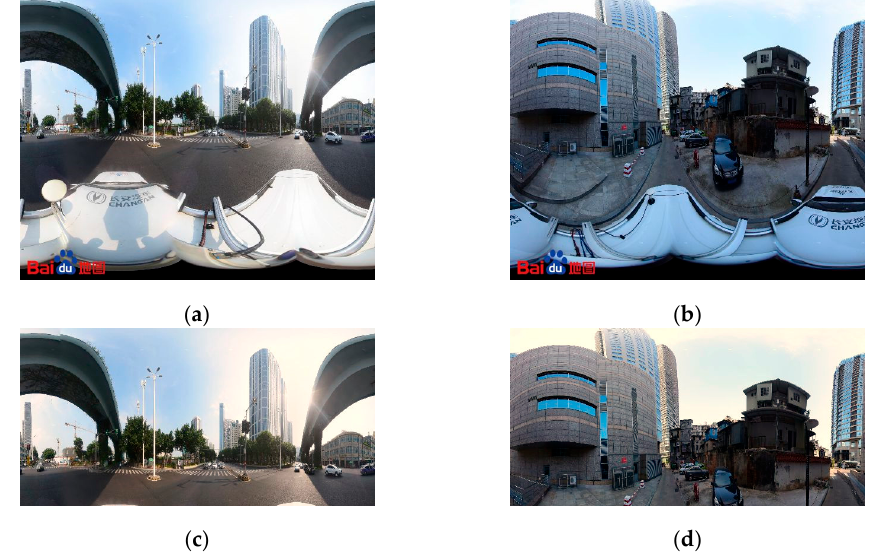
Figure 2. The preprocessing of street view images.